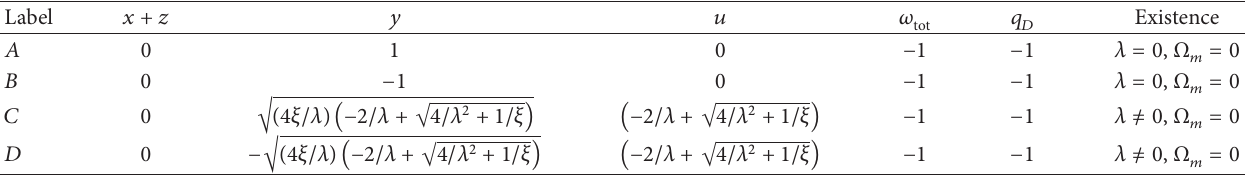
Table 1: Critical points and existence